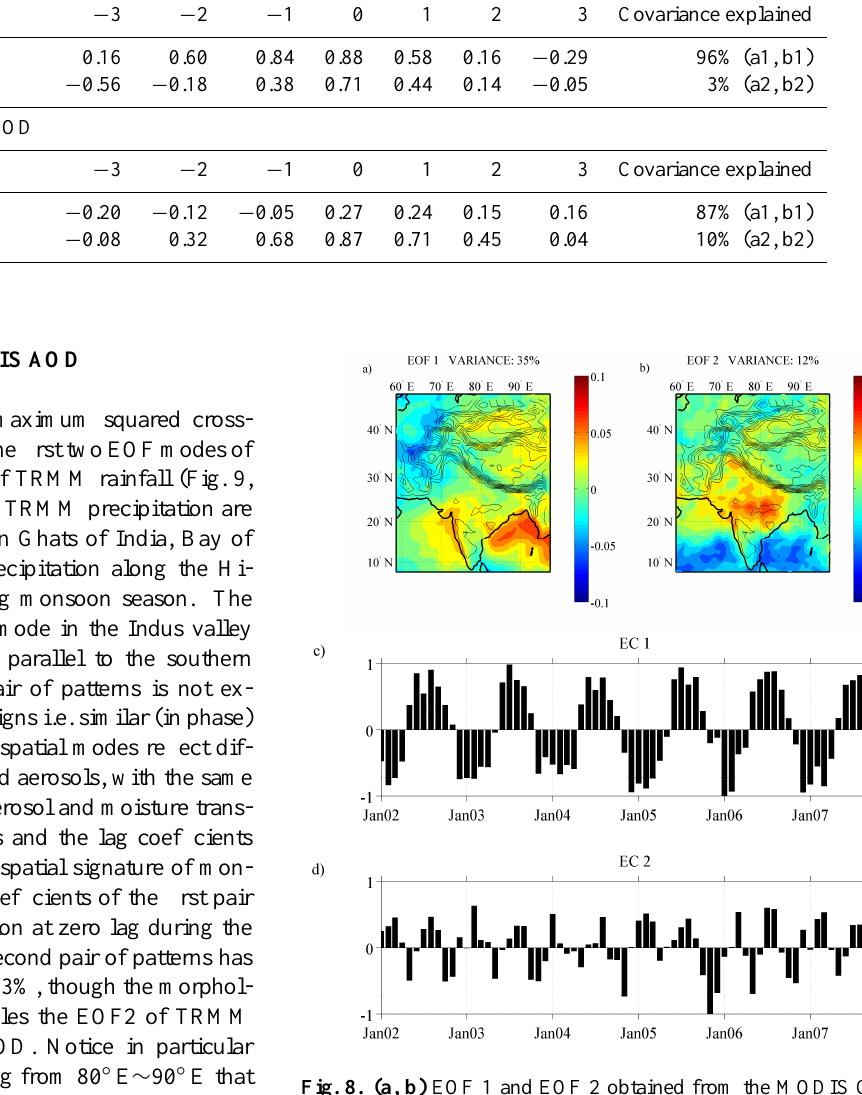
Fig. 8. (a, b) EOF 1 and EOF 2 obtained from the MODIS COD Figure 8:a,b) EOF 1 and EOF 2 obtained from the MODIS COD product. c,d) EC1 and product. (c,d) EC1 and EC2 of the corresponding EOF1 and EOF2 of the MODIS COD EC2 of the corresponding EOF1 and EOF2 of the MODIS COD respectively.